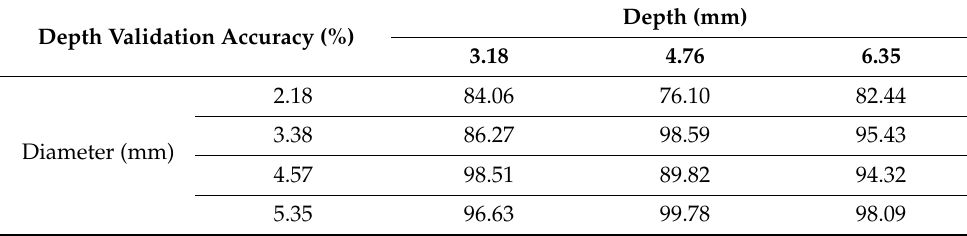
Table 12. Detailed validation accuracy of MIMO ANN model for depth